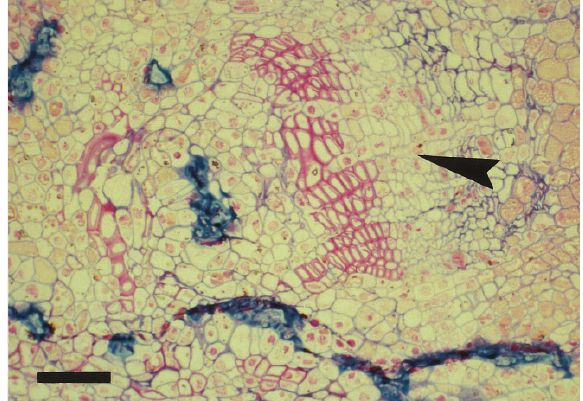
Fig. 11. Cross-section of old knots in which the tracheids (black arrows) tend to surround infected areas (white arrow). Bar=100 μ m (fuchsin-Astra blue, observed with polarised